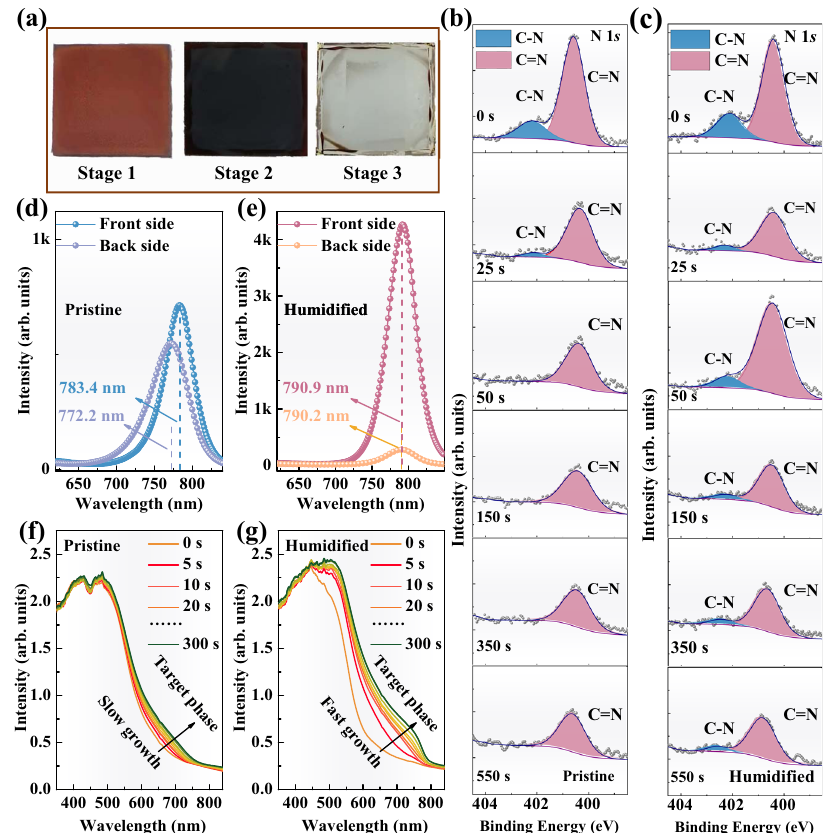
Fig. 2| Photoelectriccharacterizationofthewetintermediateperovskite fi lms (before annealing) without and withthe moisture treatment.a Photographs of wet intermediate perovskite fi lm for pristine, humidi fi ed, and over humidi fi ed samples. b , c Depth pro fi le of the XPS spectra of N 1 s peak on the pristine and humidi fi ed samples. Ar + ion beam is used to etch fi lm samples for desired